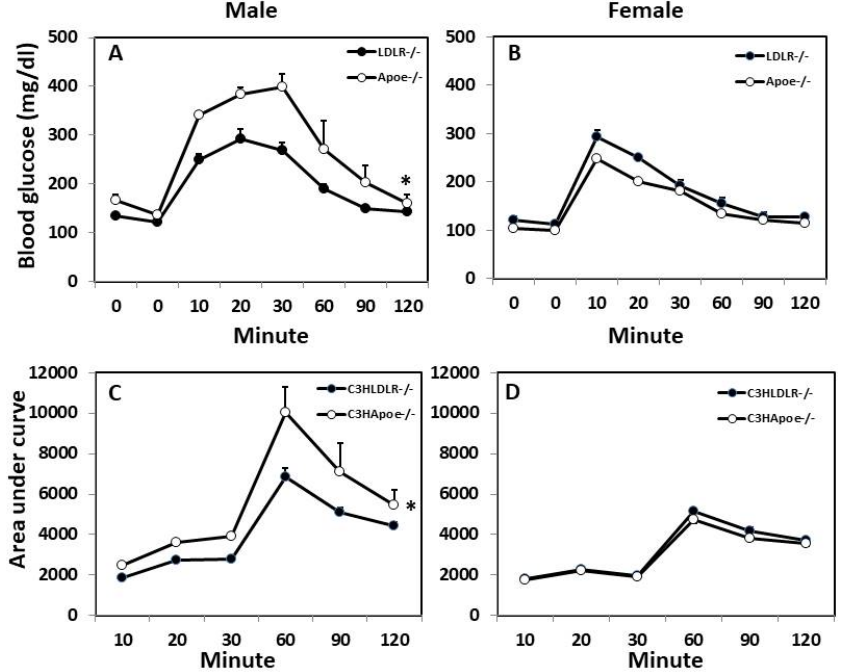
Figure 4. Glucose tolerance test (GTT) ( A , B ) and calculated area under the curve ( C , D ) for male and female C3H- Apoe -/- and C3H- Ldlr -/- mice fed a Western diet. Overnight-fasted mice were intraperitoneally injected with 1 g glucose per kg body weight. Blood glucose concentrations were determined with a glucometer using blood taken from cut tail tips at the indicated time points. Values are means ± SE of 4 to 17 mice per group. * p < 0.05 vs. Apoe -/- mice. In response to injected insulin, male C3H- Ldlr -/- mice showed a gradual fall in blood glucose levels till the 30th min, which remained low till the 45th min and recovered at the 60th min (Figure 5A). In contrast, male C3H- Apoe -/- mice showed an increase in blood glu- cose levels at the 15th min though glucose levels were comparable to the levels of C3H- Ldlr -/- mice from the 30th to 60th min (16% reduction from the basal) (Figure 5C). Female C3H- Ldlr -/- mice showed a more obvious fall in blood glucose levels than female C3H- Apoe -/- mice (47% vs. 18% decrease from the basal level) (Figure 5B,D). In addition, the basal non-fasting blood glucose level (at 0 min) was significantly higher in female C3H- Ldlr -/- mice than in the C3H- Apoe -/- counterparts (165.4 ± 13.7 vs. 118.5 ± 5.4 mg/dL; p = 0.006; n = 4 to 20).